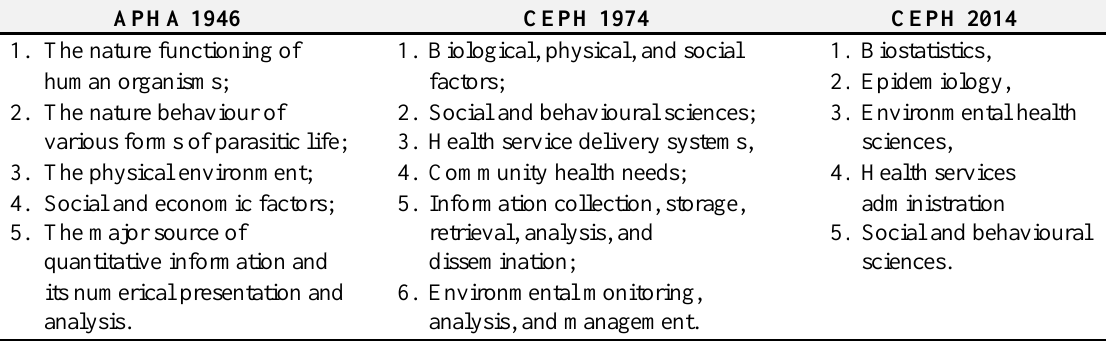
Table 1. Changes in American accreditation compulsory curricula contents 1946 to